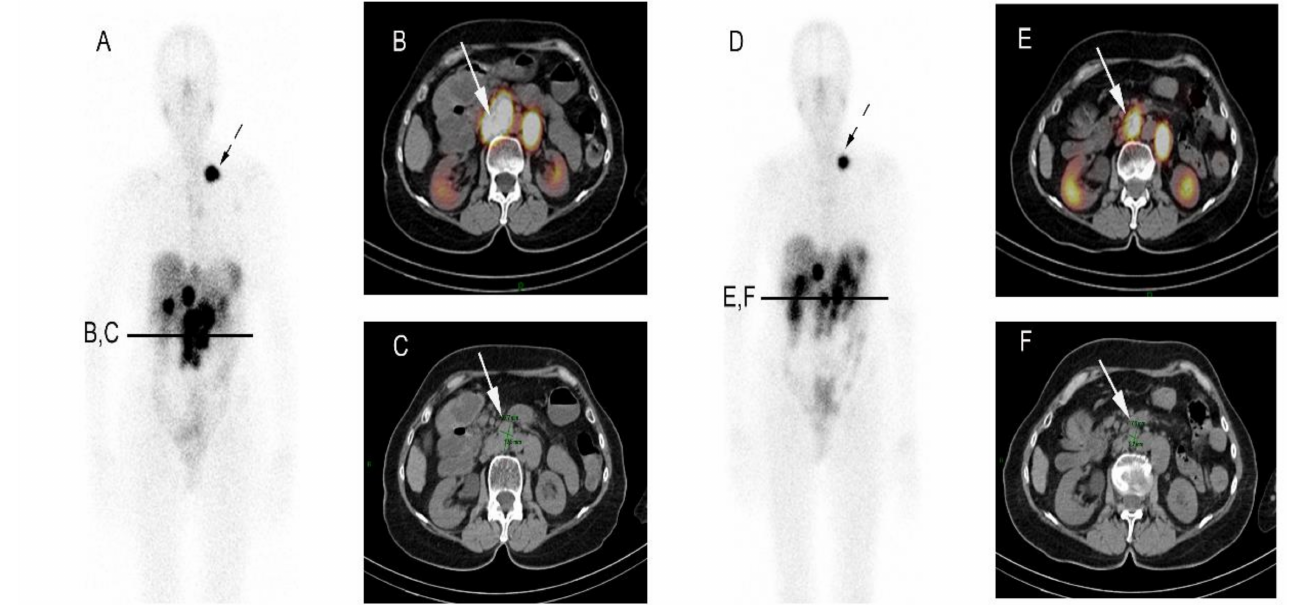
Figure 2. A 54-year-old woman with metastatic well-differentiated ileal neuroendocrine tumor, progressive under somato- statin analogs, addressed for PRRT. Post 177Lu-DOTATATE therapy whole-body image after the first administration ( A ) showed multiple foci of uptake including a large left subclavicular node (dotted arrow), liver lesions and large retroperi- toneal lymph nodes (arrow) as illustrated in axial SPECT/CT fused ( B ) and CT ( C ) images. After the fourth administration, the treatment scintigraphy already detected partial response, with a decreased uptake in several lymph nodes ( D ), particu- larly in subclavicular (dotted arrow) and para-aortic sites (arrow), also associated with decreased in size, as demonstrated in axial SPECT/CT fusion ( E ) and CT ( F )